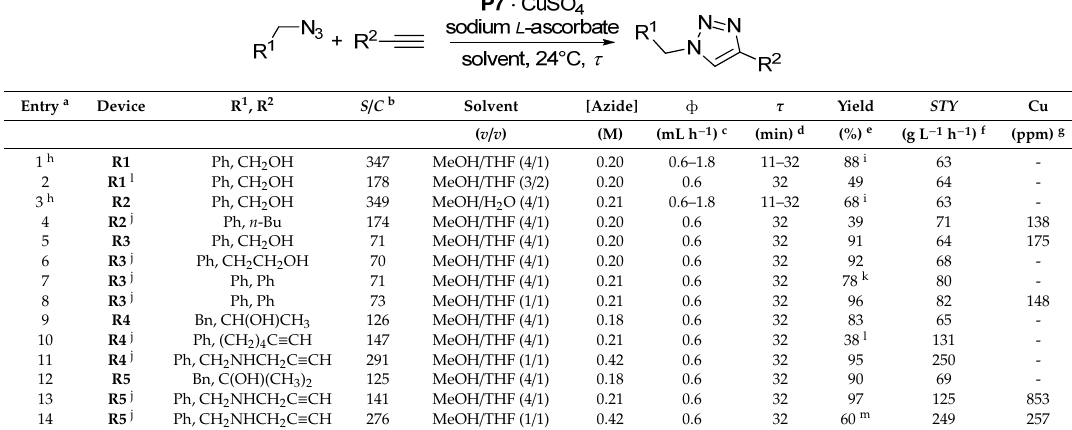
Table 3. Continuous-flow CuAAC reactions in the PCFRs containing P7 · CuSO 4 reduced with sodium L l -ascorbate.